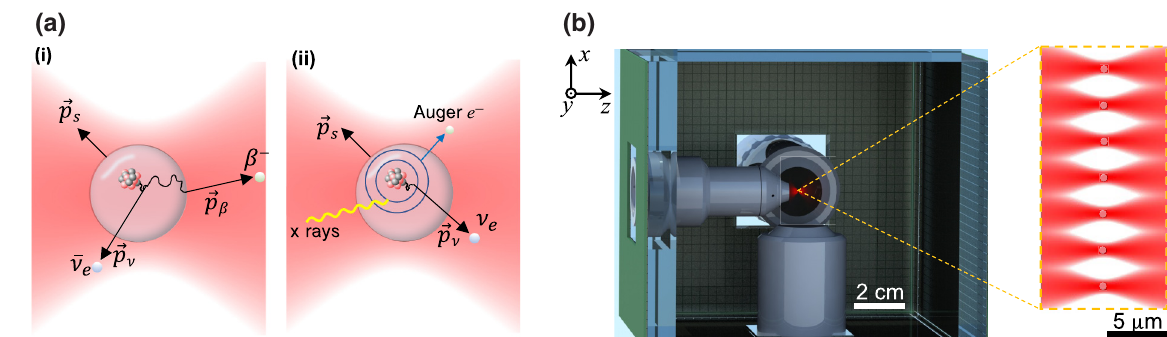
FIG. 1. A schematic of the detection concept described in the text. (a) A close-up of a single spherical nanoparticle, schematically showing (i) a β − decay, for which the nuclear recoil is stopped in the nanosphere and the e − and ¯ ν e exit the particle, and (ii) an electron- capture (EC) decay, for which only the ν e and lower-energy atomic x rays or Auger e − are emitted, such that the nanosphere recoils with a momentum nearly equal and opposite to that of the emitted ν e . (b) A cut-away view of the trap concept and surrounding detectors. The trap is formed by a low-profile high-numerical-aperture objective, with two additional long-working-distance objectives positioned perpendicularly to the trapping objective to collect scattered light. Scintillator panels instrumented with SiPM arrays surround the trap on all sides to reconstruct emitted secondary particles. The inset shows an enlargement of the trapping region, schematically showing traps for multiple particles formed with a tweezer array